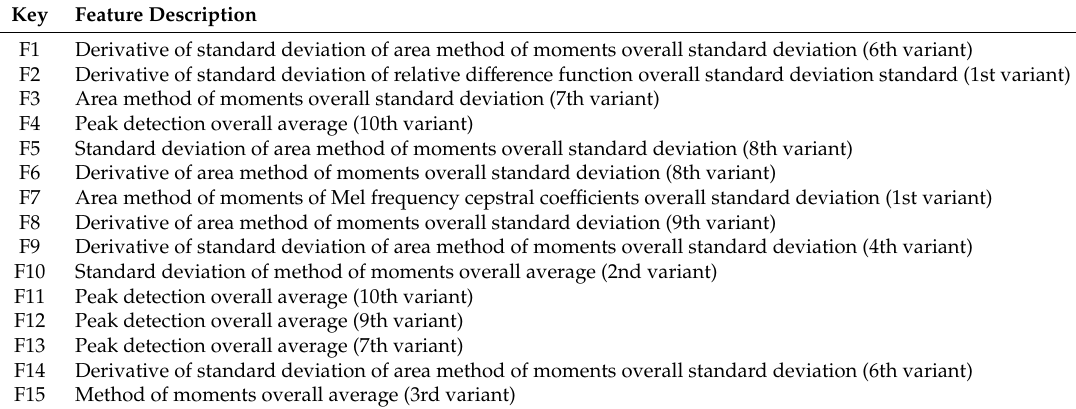
Table 4. Description of the top 20 acoustic